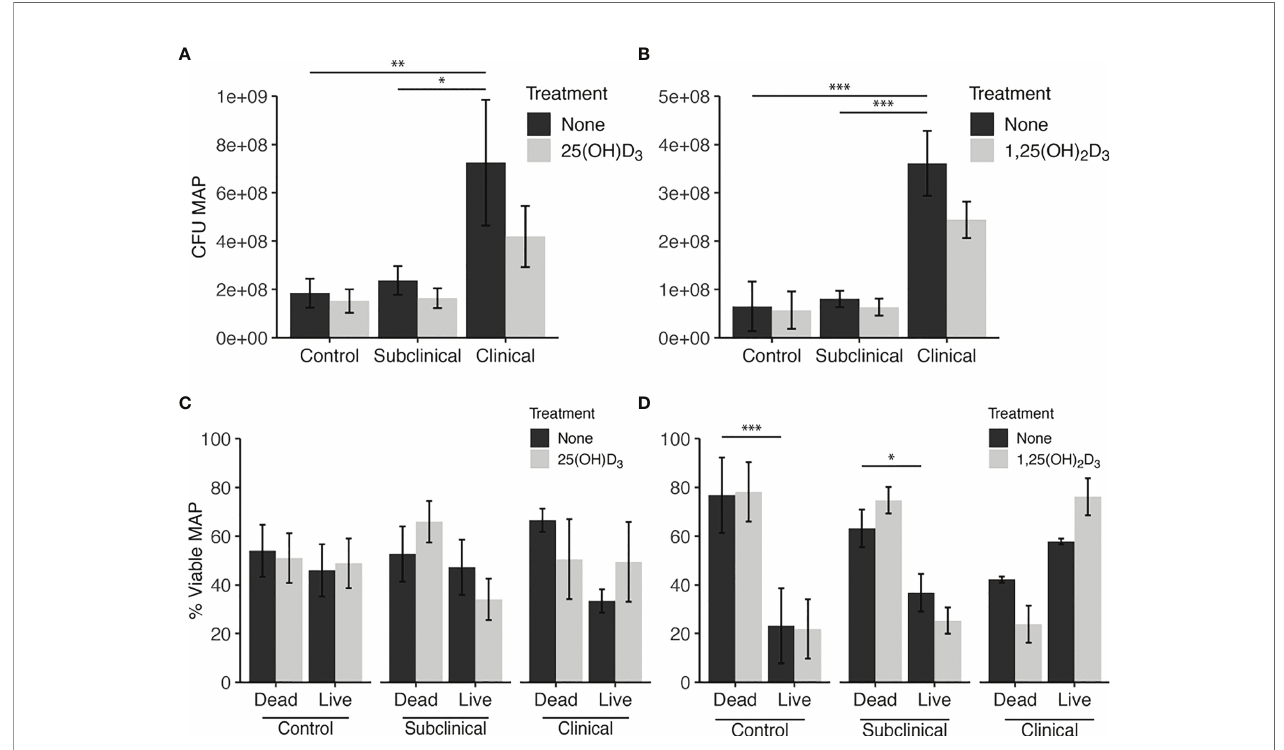
FIGURE 3 | Quantitation of Mycobacterium avium subsp. paratuberculosis (MAP) present within monocyte-derived macrophages (MDMs) cultured from naturally infected dairy cattle (subclinical n=8, clinical n=8, and noninfected controls n=8). Viable intracellular MAP colony forming units (CFUs) were quanti fi ed using PMAxx dye and IS900 gene ampli fi cation via real time qPCR and standard curve. (A, B) show CFU recovered from samples. (C, D) show proportion of viable MAP that was calculated from PMAxx viability CFU data divided by the number of MAP inoculated in MDM cultures to achieve a 10:1 MOI. Data are presented as the mean ± SE and signi fi cance is de fi ned as *< 0.05, **< 0.01, ***<